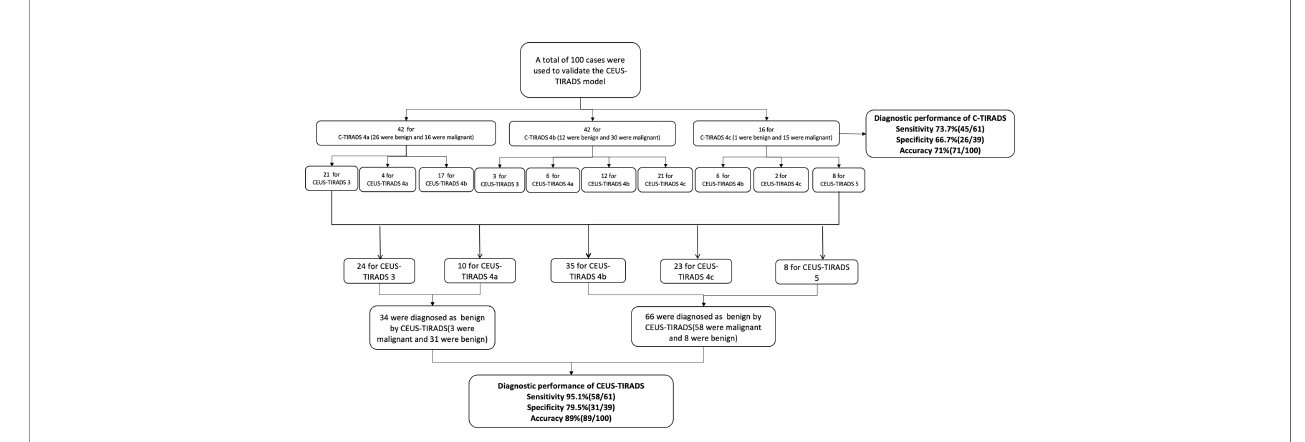
FIGURE 7 | The process of validation of